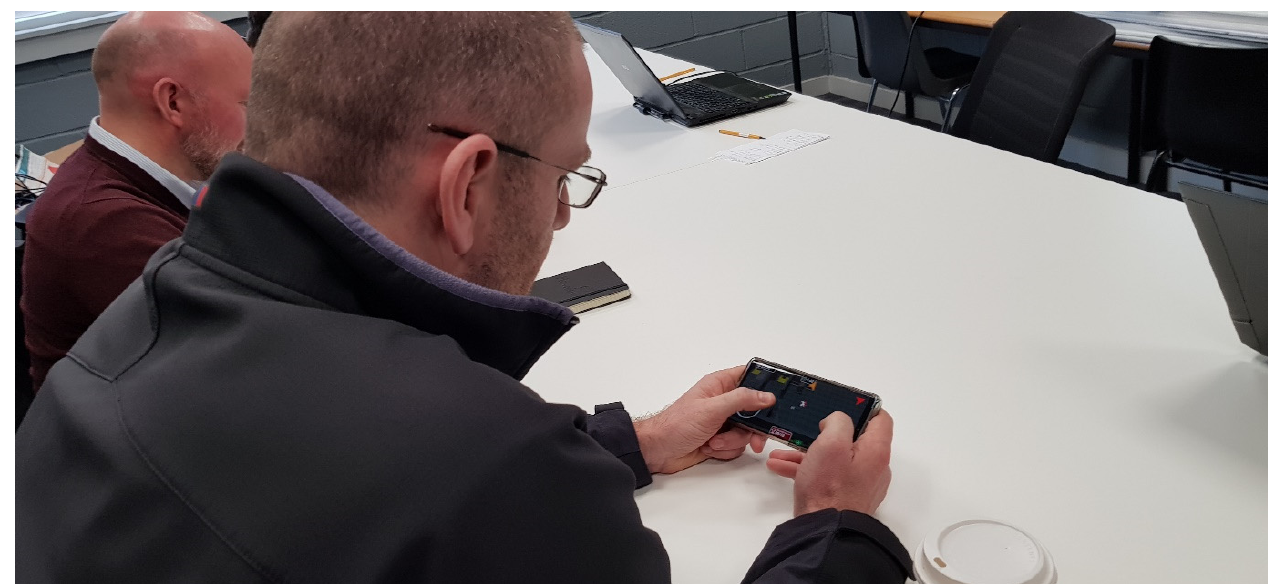
Figure 6. Participants from the Howden group playtesting the serious game.